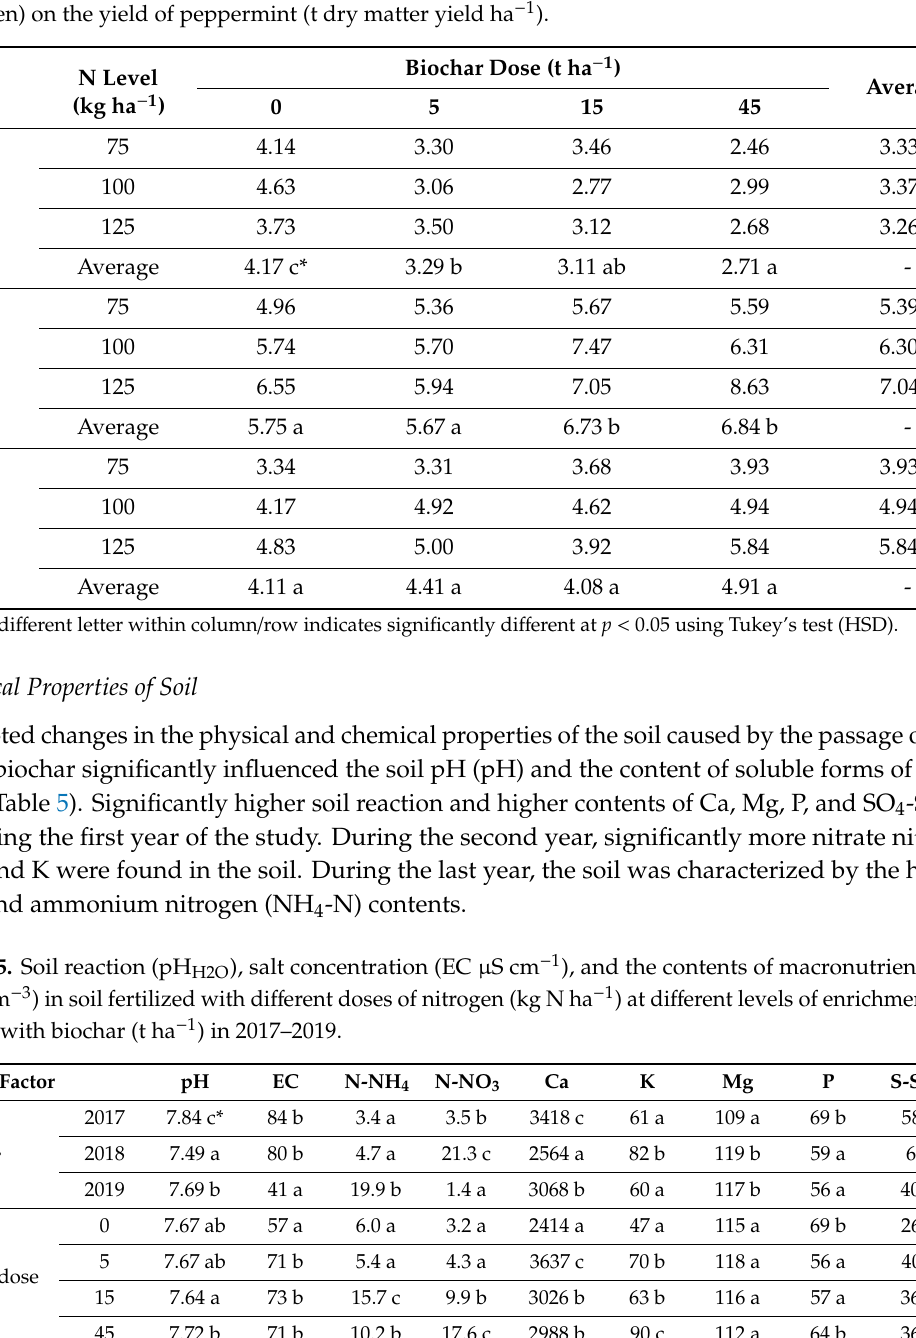
Table 4. The interaction of the experimental factors (year, dose of biochar, and dose of fertilizing nitrogen) on the yield of peppermint (t dry matter yield ha − 1 ).